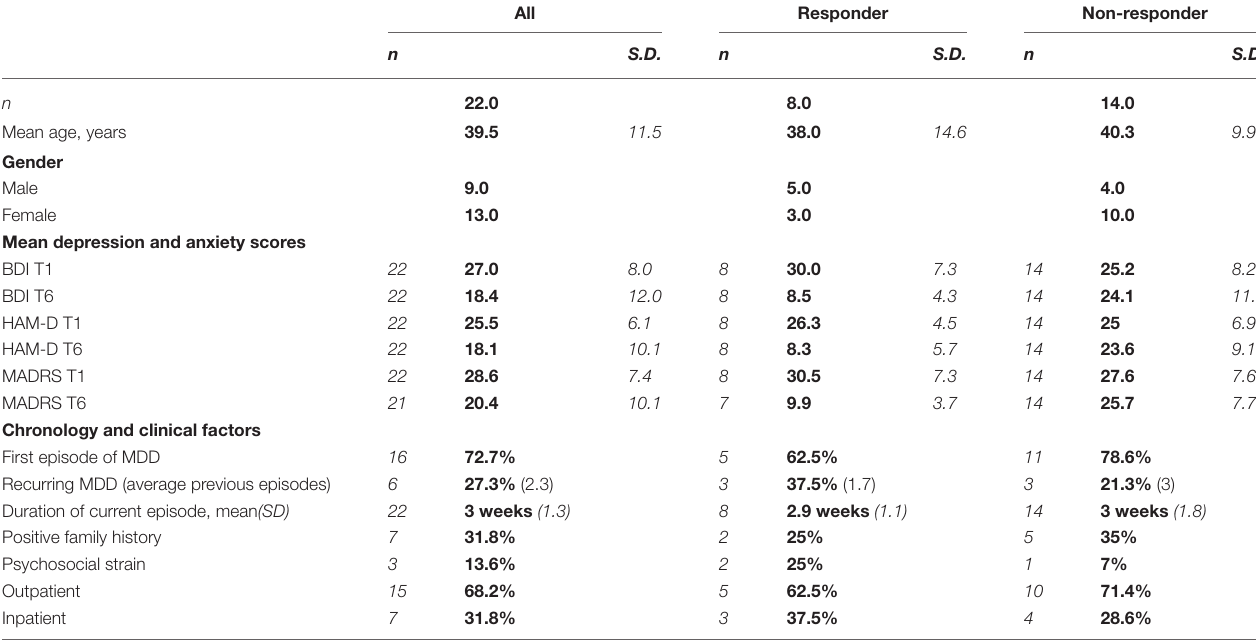
TABLE 1 | Demographics, questionnaires and clinical factors of